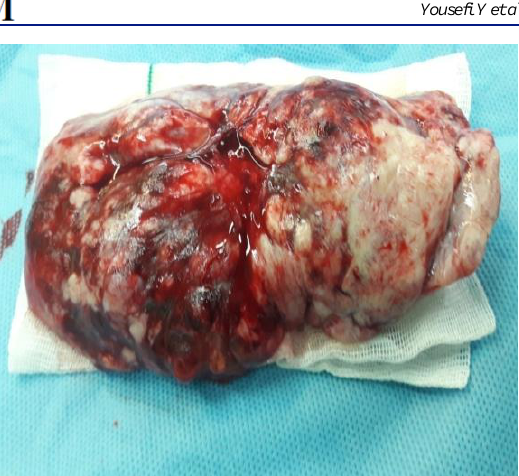
Figure 2. CT scan of patient with SFT Figure 3. Macroscopic view of SFT after surgical resection